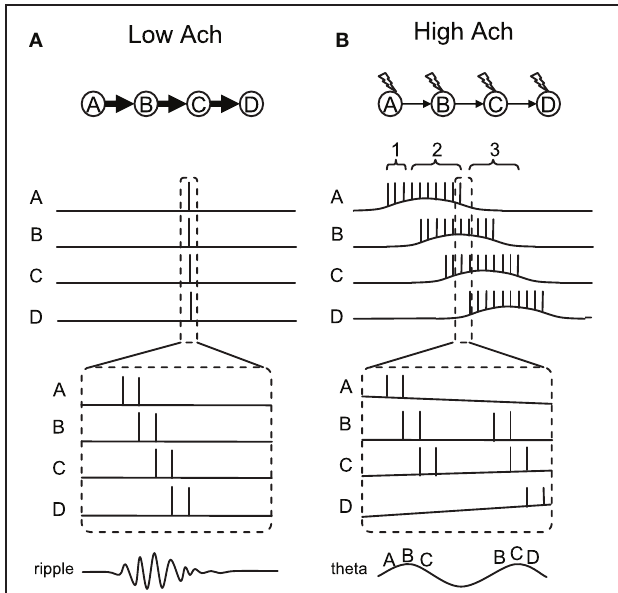
FIGURE 5 | Conceptual model of dynamics switching. Place cells A–D are sequentially connected by asymmetric synaptic connections. (A) Place cell firing in slow-wave-sleep and quiet waking with low acetylcholine. In this mode, strong synaptic transmission enables neural activity to propagate fast and activate all place cells sequentially within a few hundred milliseconds. (B) Place cell firing in active waking with high acetylcholine. In this mode, synaptic transmission is suppressed. However, a few spikes in each neuron activate the CAN current and drive persistent firing. Persistent firing will eventually cause enough temporal summation of EPSP in the cell downstream in the sequence. Sequential firing will occur at a much slower time scale compared to (A) because each neuron needs to activate the CAN current and drive persistent firing. Thick and thin arrows show strong and weak synaptic transmissions, respectively. Lightning signs in (B) show cholinergic receptor